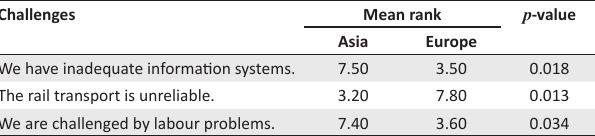
TABLE 2: Mann-Whitney test: Significant differences in views on supply